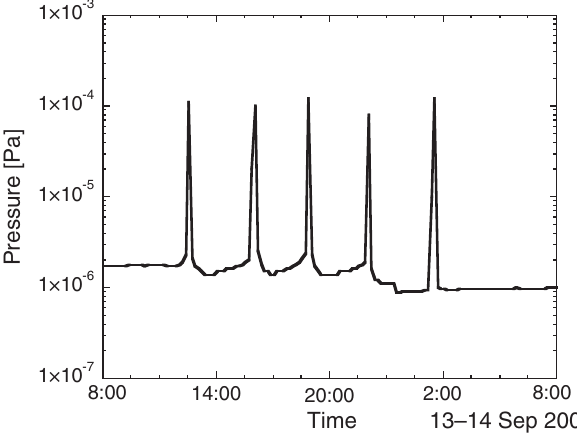
FIG. 4. Pressure instability caused by the ion